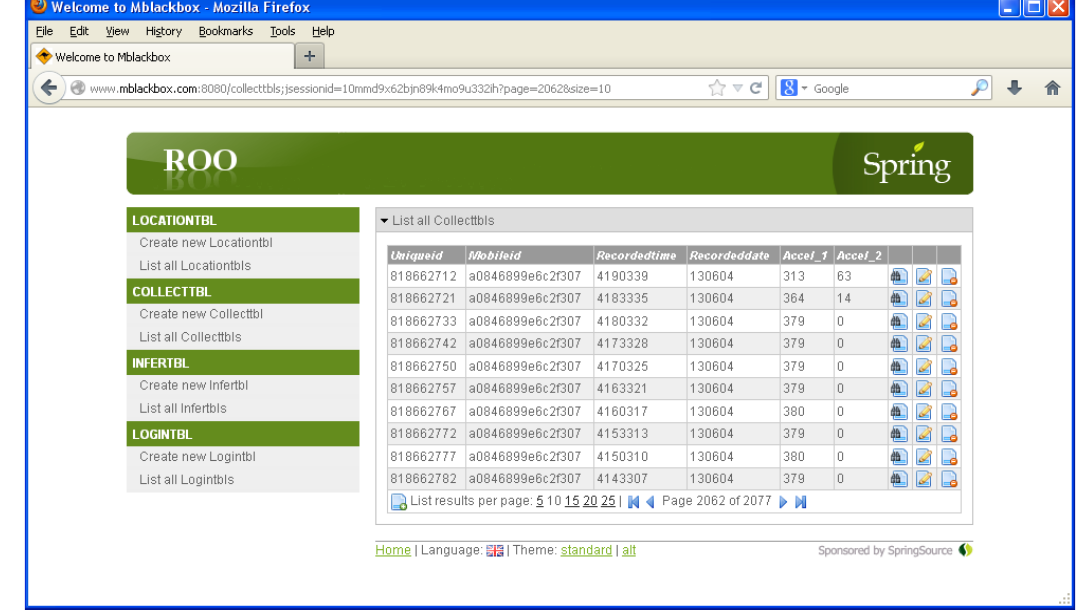
Figure 7. Collection server using Spring Roo.